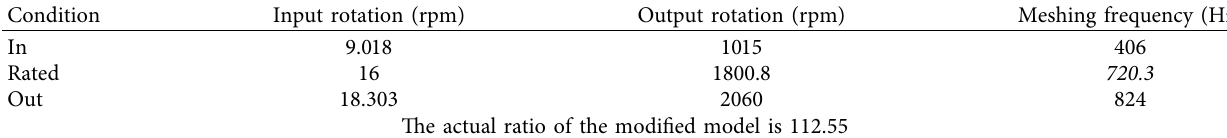
Table 7: Gear mesh frequencies of modified parallel-axis helix stage.